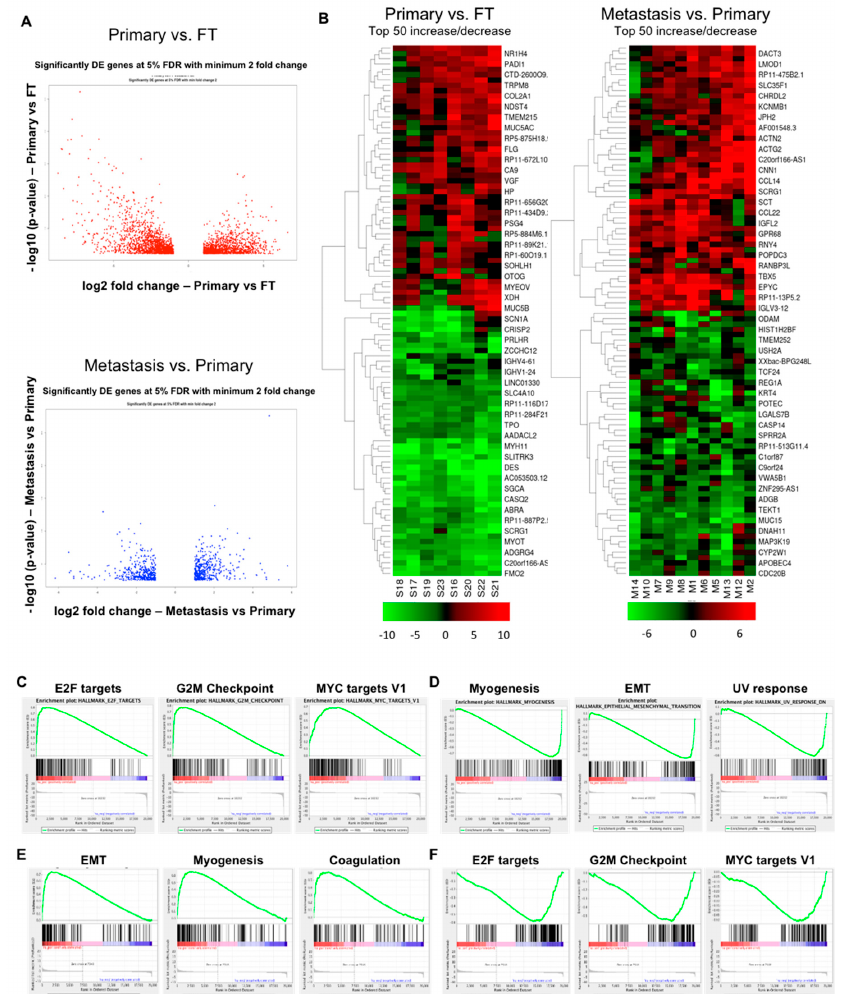
Figure 1. Gene expression analysis of ovarian carcinogenesis and progression. ( A ) Top: Volcano plot representing di ff erentially expressed (DE) genes for primary tumors versus fallopian tube. Bottom: Volcano plot representing di ff erentially expressed genes for metastasis versus primary tumors. The -log10 ( p -values) plotted against log2 fold change values for all the significantly di ff erentially expressed genes at 5% false discovery rate (FDR) with at least a two-fold change between Primary versus fallopian tube tumors (FT) (top) and Metastasis versus Primary tumors (bottom). The dots on the negative and positive values of X-axis in the top figure represent downregulated and upregulated genes, respectively, in Primary tumors relative to FT. The bottom figure represents the same in metastatic tumors relative to primary tumors. ( B ) Heat map representing top 50 upregulated and downregulated genes (fold change, at least 5% FDR) in primary tumors versus fallopian tube (Left) and in metastasis versus primary tumors (Right). Elevated gene expressions are depicted by increasingly deeper shades of red, while the diminished levels of expression are indicated by deeper shades of green. ( C ) Gene set enrichment analysis (GSEA) in primary tumors versus fallopian tube (positively correlated). ( D ) Primary tumors versus fallopian tube (negatively correlated). ( E ) GSEA in metastasis versus primary tumors (positively correlated). ( F ) Metastasis versus primary tumors (negatively